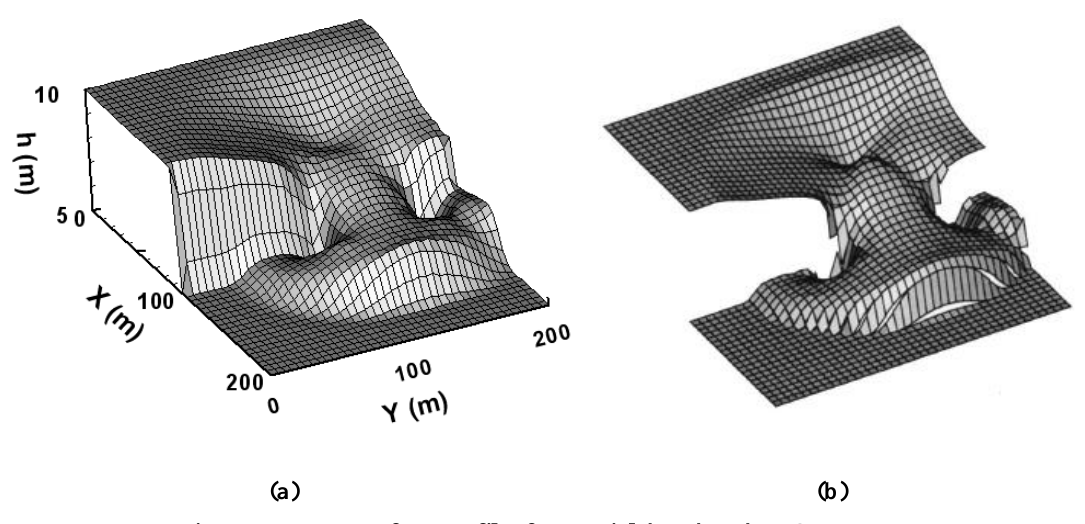
Figure 7. Water surface profiles for partial dam-break at t = 7.2